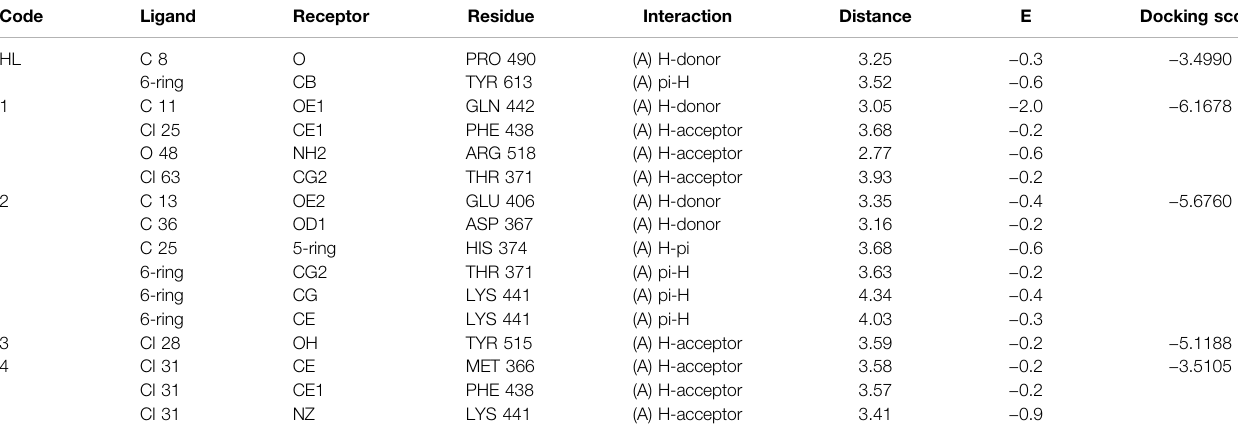
TABLE 6 | Ligand acid ( HL ) and complexes 1 – 4 interaction report with angiotensin converting enzyme (ACE2).